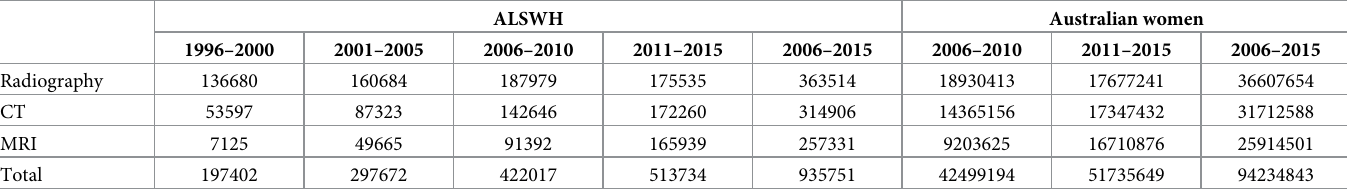
Table 3. Costs of lumbar spine imaging in the ALWSH cohort from 1996 to 2015 and cost estimates from 2006 to 2015 for Australian women aged 25–34 years in 2006, AU$.